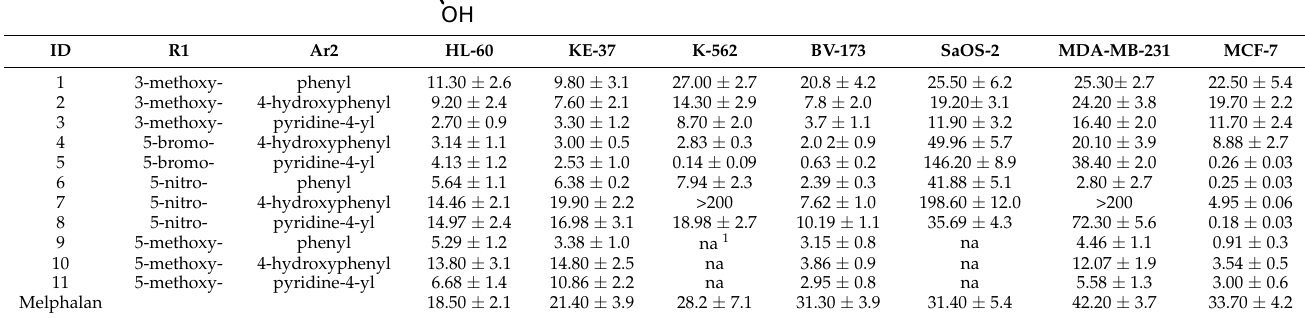
Table 1. IC 50 values ± standard deviations of the compounds from the training set used in the SAR analyses. The anticancer activities of the compounds were measured on four leukemia cell lines (HL-60, KE-37, K-562, and BV-173), one osteosarcoma cell line (SaOS-2), one breast ER+ adenocarcinoma cell line (MCF-7), and one TNBC cell line (MDA-MB-231). Melphalan was used as a positive control.